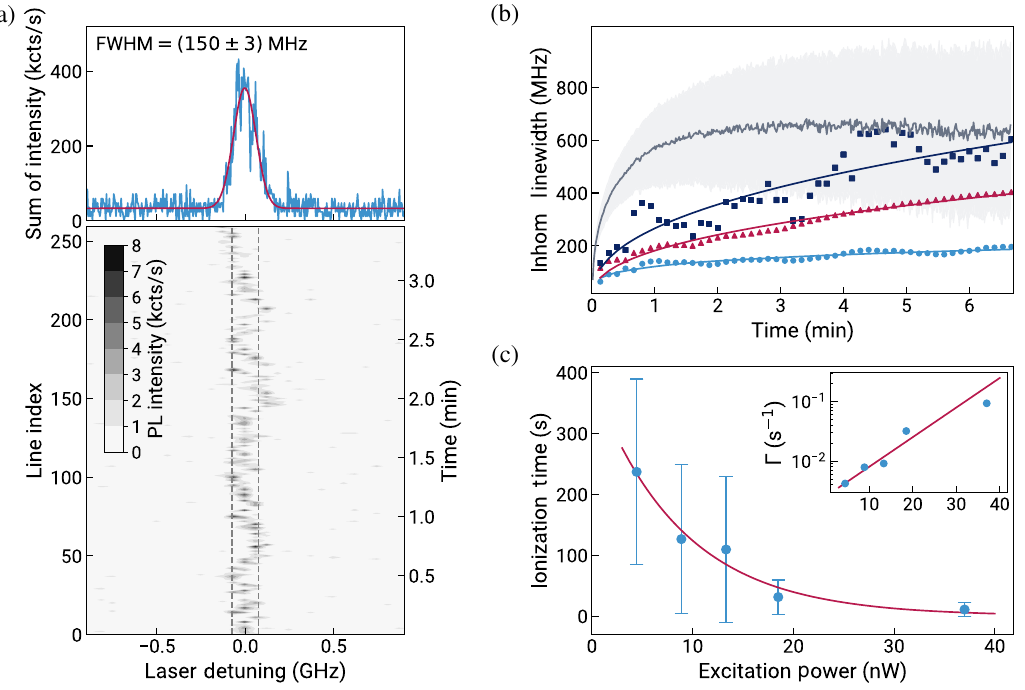
FIG. 2. Inhomogeneous linewidth and ionization time (regime 1). (a) More than 250 PLE scans performed without reinitialization of the NV with green laser pulses. The excitation power of the resonant laser is 2 nW, and the scan speed is 50 GHz = s (bottom). The inhomogeneous linewidth is given by the intensity sum of all scanned lines recorded over a time of more than three minutes and is fitted by a Gaussian function (top). The determined FWHM of ð 150 (cid:2) 3 Þ MHz is indicated by dashed lines (bottom). (b) Cumulative inhomogeneous linewidth evolution in time. Data of the single trajectory corresponding to the PLE scans in (a) ( n ¼ 1 , blue circles), average of postselected trajectories ( n ¼ 14 , red triangles), and all trajectories ( n ¼ 42 , dark blue squares) are shown. The simulated data (gray line) are obtained from modeling a normal diffusion process. The experimental data are fitted by a power law γ exponents a ¼ 0 . 22 (blue line), a ¼ 0 . 41 (red line), and a ¼ 0 . 42 (dark blue line). A scaling exponent a < 1 is characteristic for subdiffusive processes. (c) Average ionization time for different excitation powers extracted from many tens of PLE data sets recorded at a scan speed of 12 GHz = s. The uncertainty is given by the standard deviation of the individual ionization times. The ionization time decays exponentially for increased excitation power with a power constant of ð 8 . 7 (cid:2) 1 . 4 Þ nW. The NV transition is driven at a duty cycle of about 0.2%. Inset: ionization rate Γ as a function of excitation